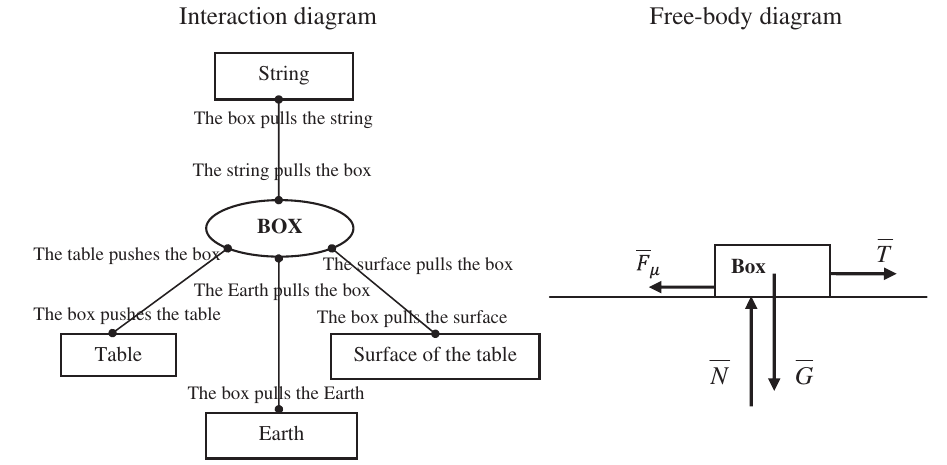
FIG. 1. The ID and the corresponding FBD when a box is pulled with a string along a table at constant